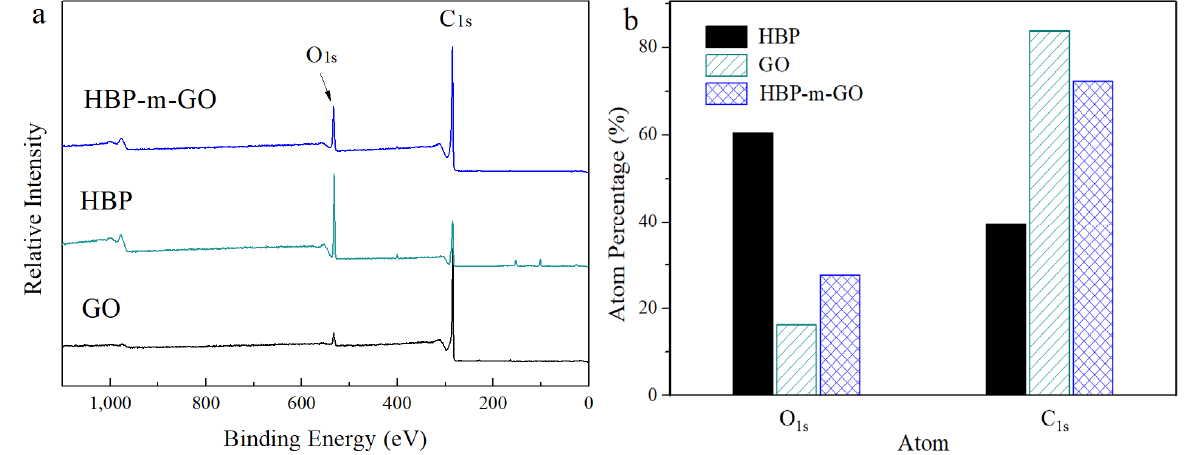
Figure 1. ( a ) XPS profiles of HBP, GO, and HBP-m-GO and ( b ) atomic percentages of O 1s and C 1s .